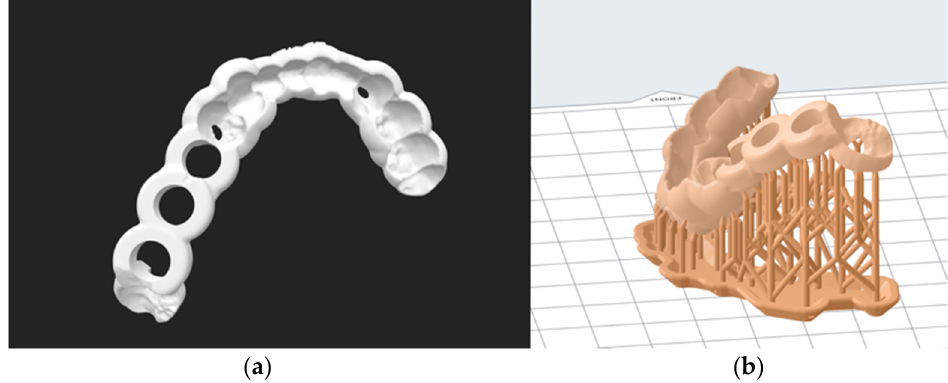
Figure 1. ( a ) STL planning file and ( b ) print preparation (here for the Form 3 using PreForm).